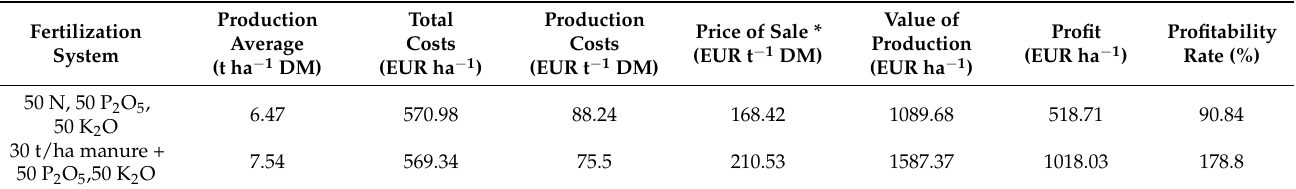
Table 7. The influence of the agricultural fund on the economic efficiency of the meadow sown in Horezu – Vâlcea, Romania (average 2018 – 2020).